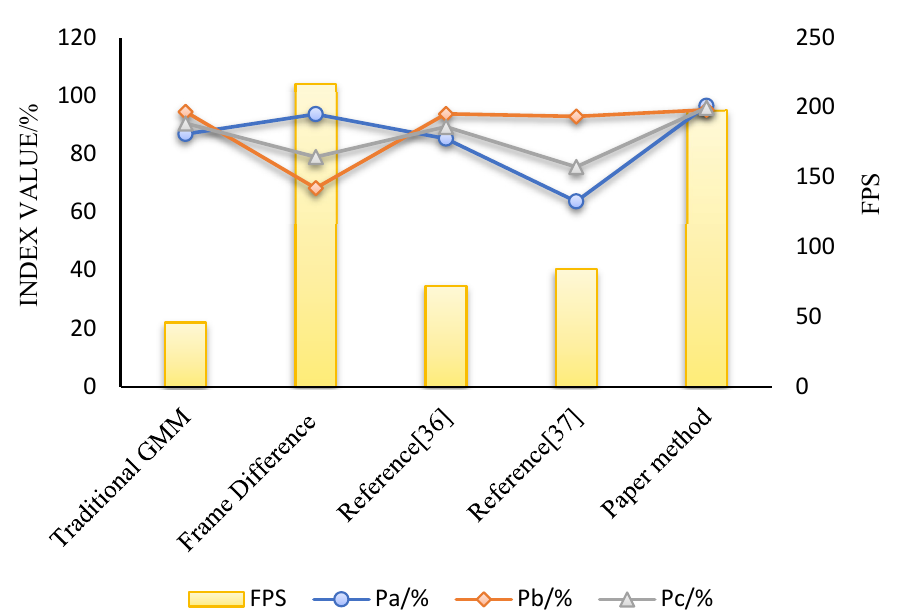
Figure 17. Distribution diagram of evaluation indicators for each algorithm.